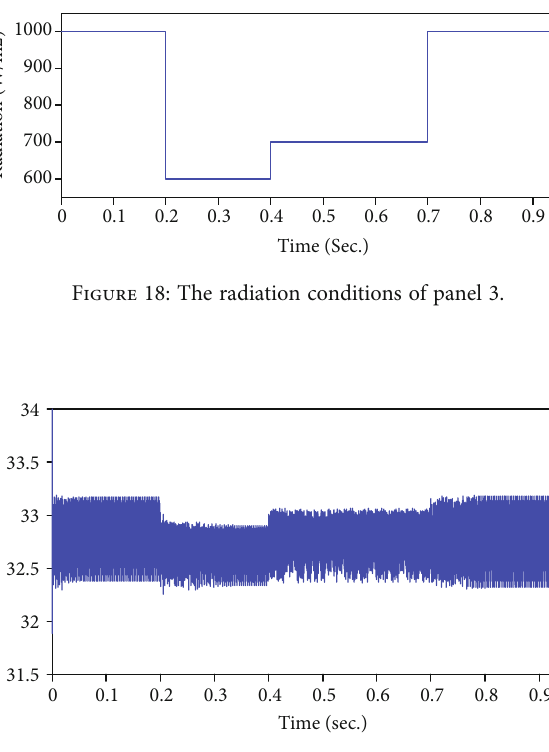
Figure 19: Voltage of PV1.